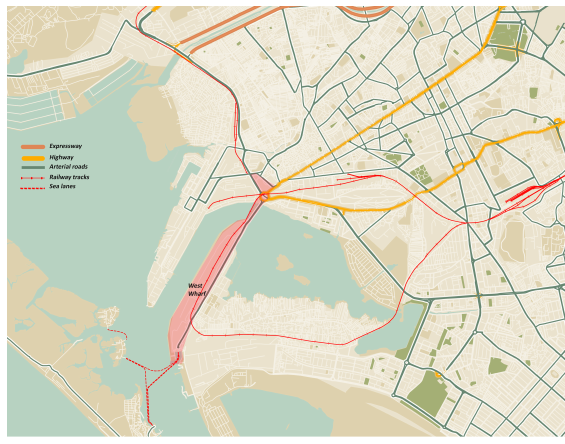
Figure 6. Connection of the port in Urban setup.